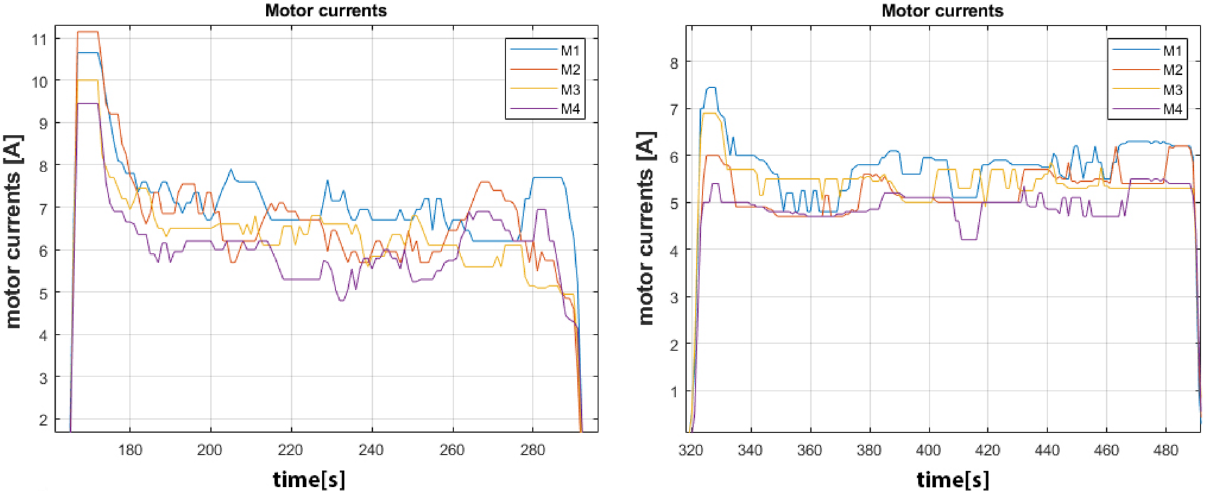
Figure 11. Currents drawn by motors over asphalt, on the left, and over concrete, on the right, during straight